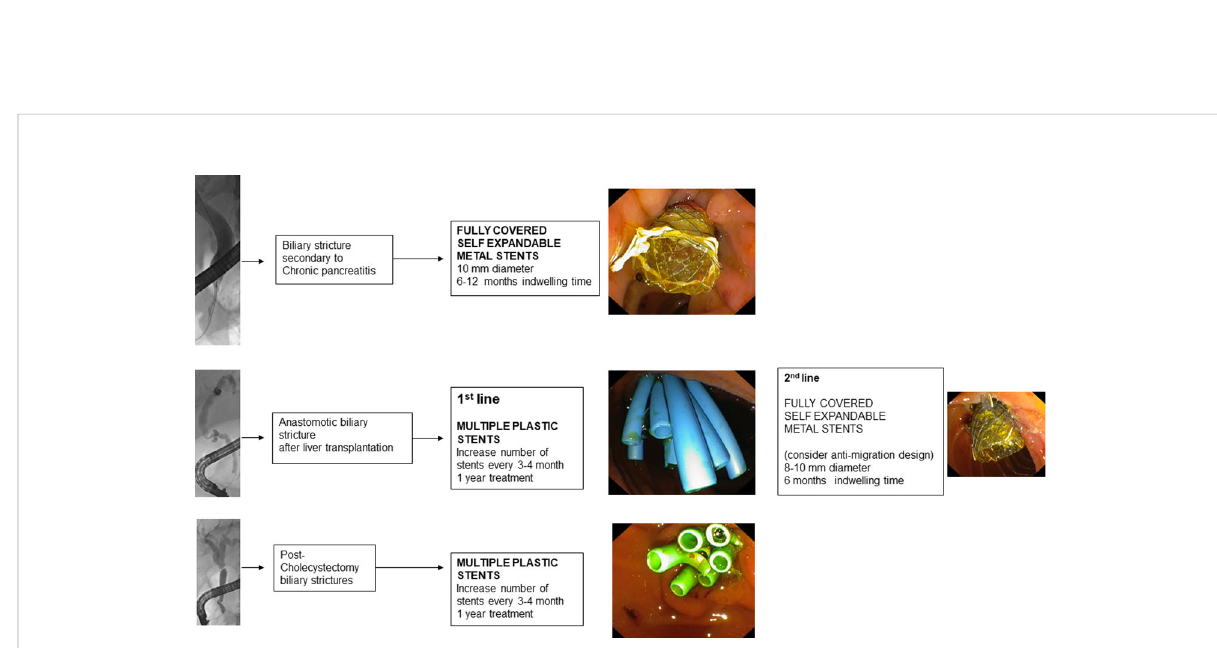
FIGURE 3 Benign biliary strictures and choice of the